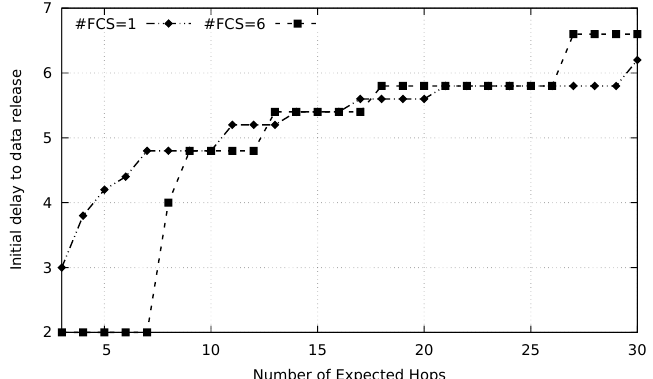
Figure 5. Optimal initial delay (in t data ) to release data as a function of the number of hops between source (S) and destination (D). Minimal initial delay limited in 2 data transmission